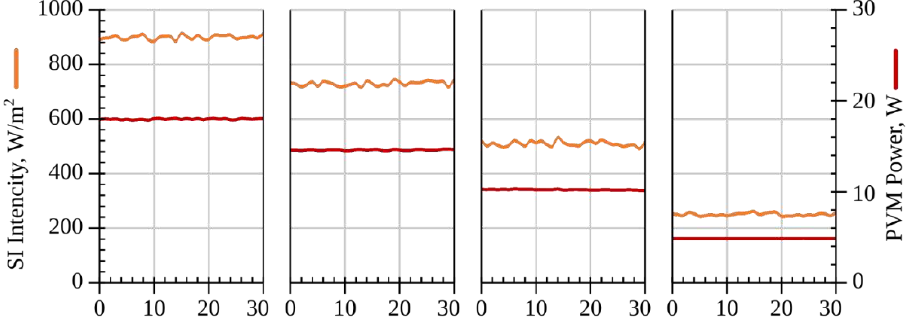
Figure 11. Indicators of the SI intensity and the power consumed from the PVM to the lighting system.